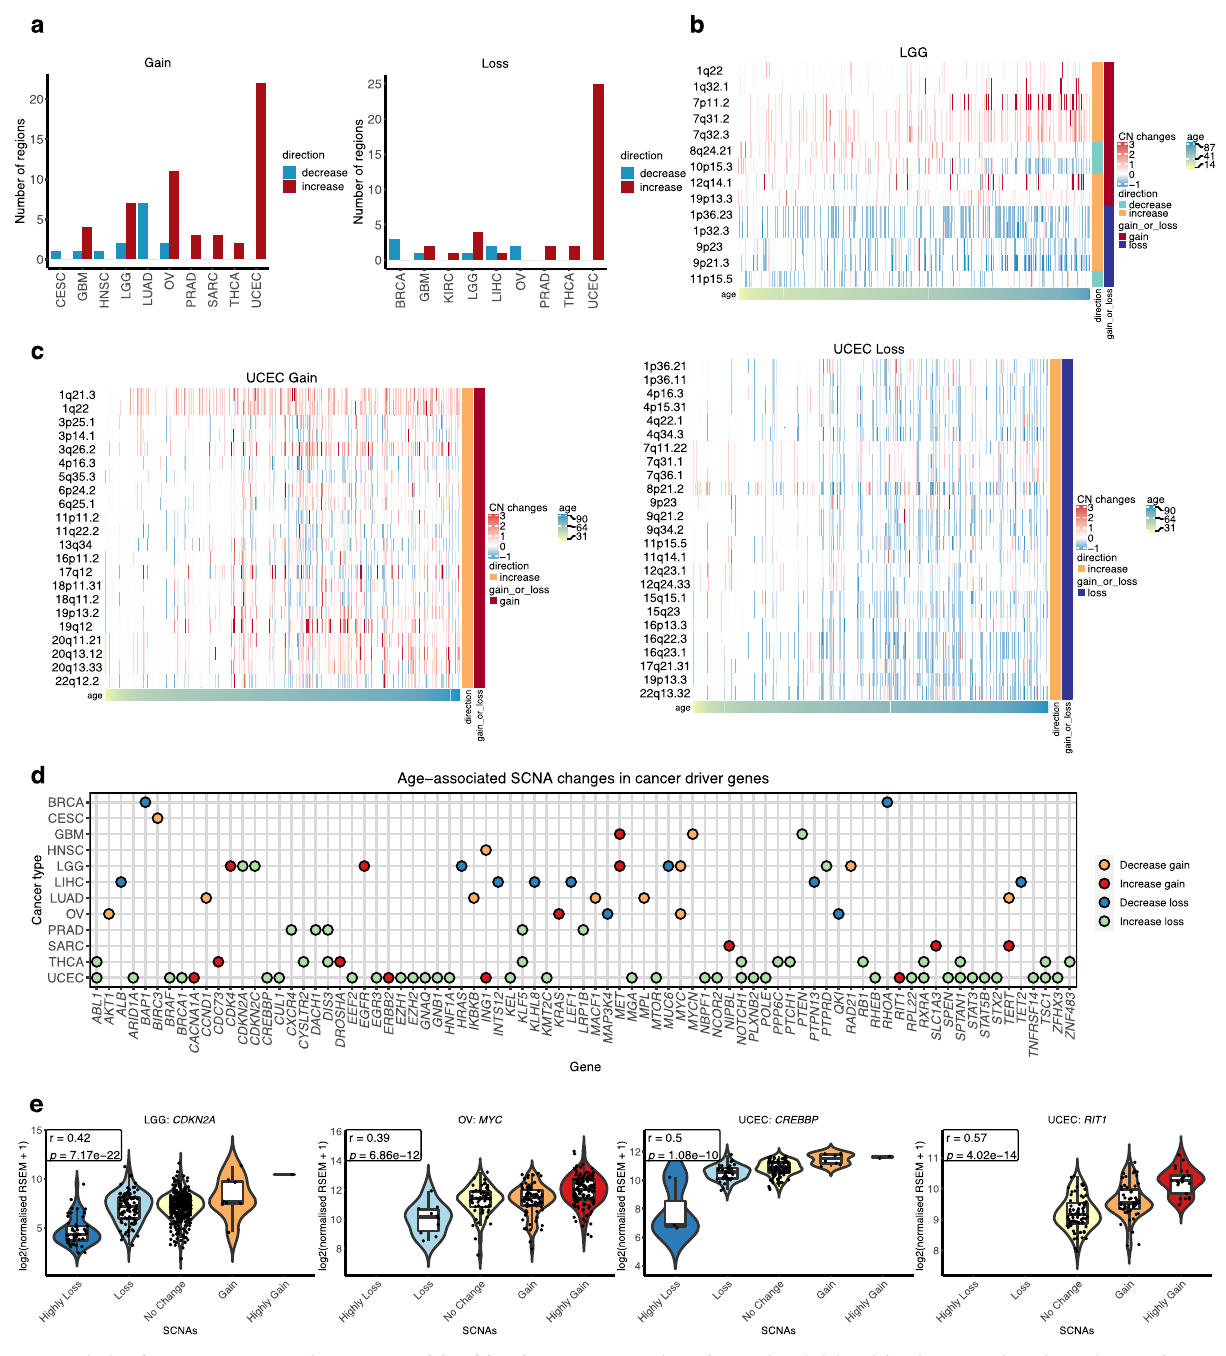
Fig. 3 Association between cancer patients ’ age and focal-level SCNAs. a Number of gained and deleted focal regions that showed a signi fi cant association with age per cancer type (multiple logistic regression, adj. p value < 0.05). Multiple-hypothesis testing correction was done using Benjamini – Hochberg procedure. Heatmap showing age-associated focal-level SCNAs in ( b ) LGG and ( c ) UCEC. Samples are sorted by age. Colours represent copy-number changes from GISTIC2.0, blue denotes loss and red corresponds to gain. The gain_or_loss legend demonstrates that the region is recurrently gained or deleted. The direction legend shows whether the gain/loss of the region increases or decreases with age. d Age-associated SCNA changes in cancer-driver genes. Cancer-driver genes located in the age-associated focal regions are plotted by cancer type. Colours of the dot represent the condition of the focal region where the gene located in as follows: blue — decrease loss; green — increase loss; yellow — decrease gain; and red — increase gain with age. e The effect of copy-number changes on gene expression of CDKN2A in LGG (Highly Loss n = 50, Loss n = 102, No Change n = 327, Gain n = 8, Highly Gain n = 1 samples), MYC in OV (Highly Loss n = X, Loss n = 10, No Change n = 56, Gain n = 82, Highly Gain n = 140 samples), CREBBP (Highly Loss n = 3, Loss n = 36, No Change n = 101, Gain n = 8, Highly Gain n = 2 samples) and RIT1 (No Change n = 72, Gain n = 53, Highly Gain n = 25 samples) in UCEC. These are examples of genes with age-associated changes in SCNAs. Violin plots show the log2 (normalised expression + 1) of samples grouped by their SCNA status. Pearson correlation coef fi cient r and p value (two-sided test) are shown in the fi gures. The middle bar of the boxplot is the median. The box represents interquartile range (IQR), 25 – 75th percentile. Whiskers represent a distance of 1.5 × IQR. TCGA cancer type acronyms and their associated name are provided in Table